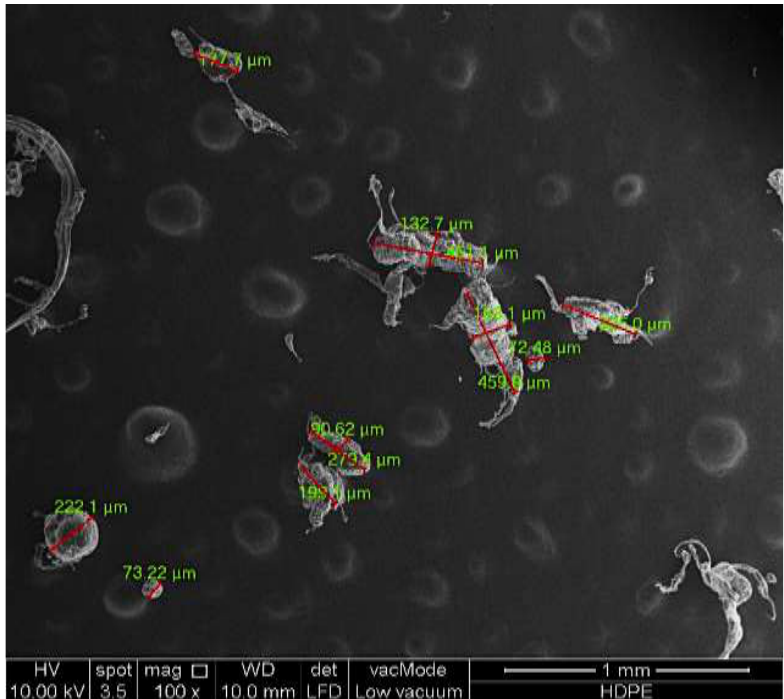
Figure 1: A representative image of the polyethylene microplastics viewed under field emission scanning electron microscope (FESEM). Abbreviations: HV= voltage, spot = spot size, mag = magnification, WD = working distance, det = detector, LFD = large-field detector (pre-selected for non-conductive samples), vacMode = vacuum mode, HDPE = high density polyethylene (sample